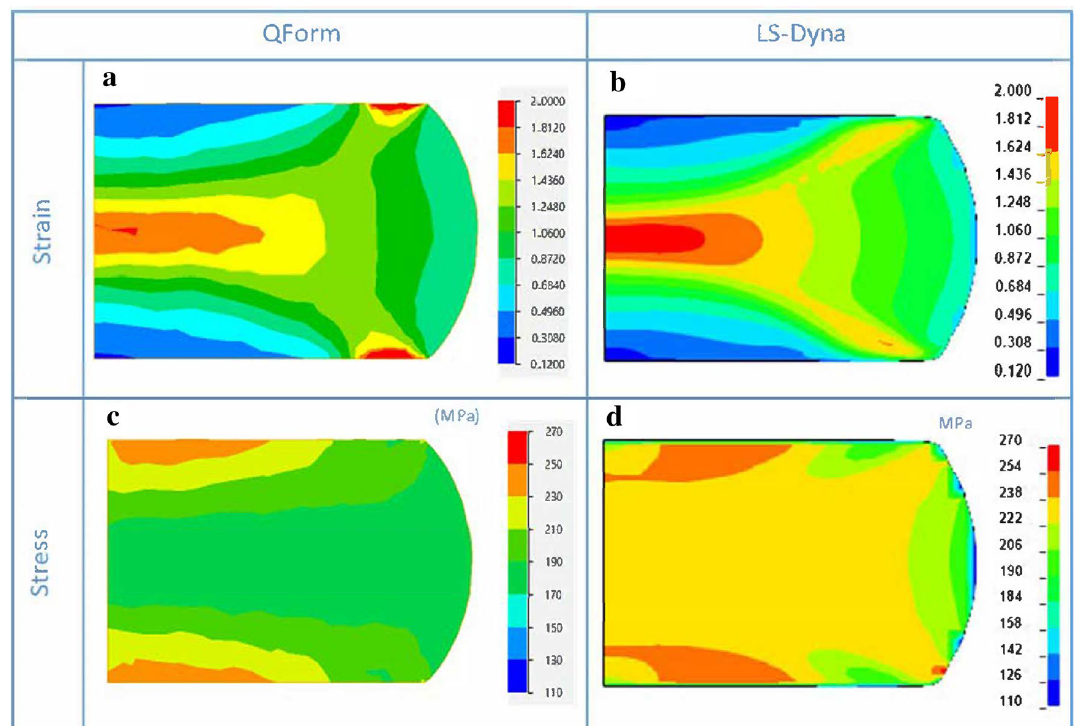
Fig. 7 Comparison of strain rate distribution at 1000 °C and 30 1/s for three different stages during compression: 33, 66, and 100% of total stroke